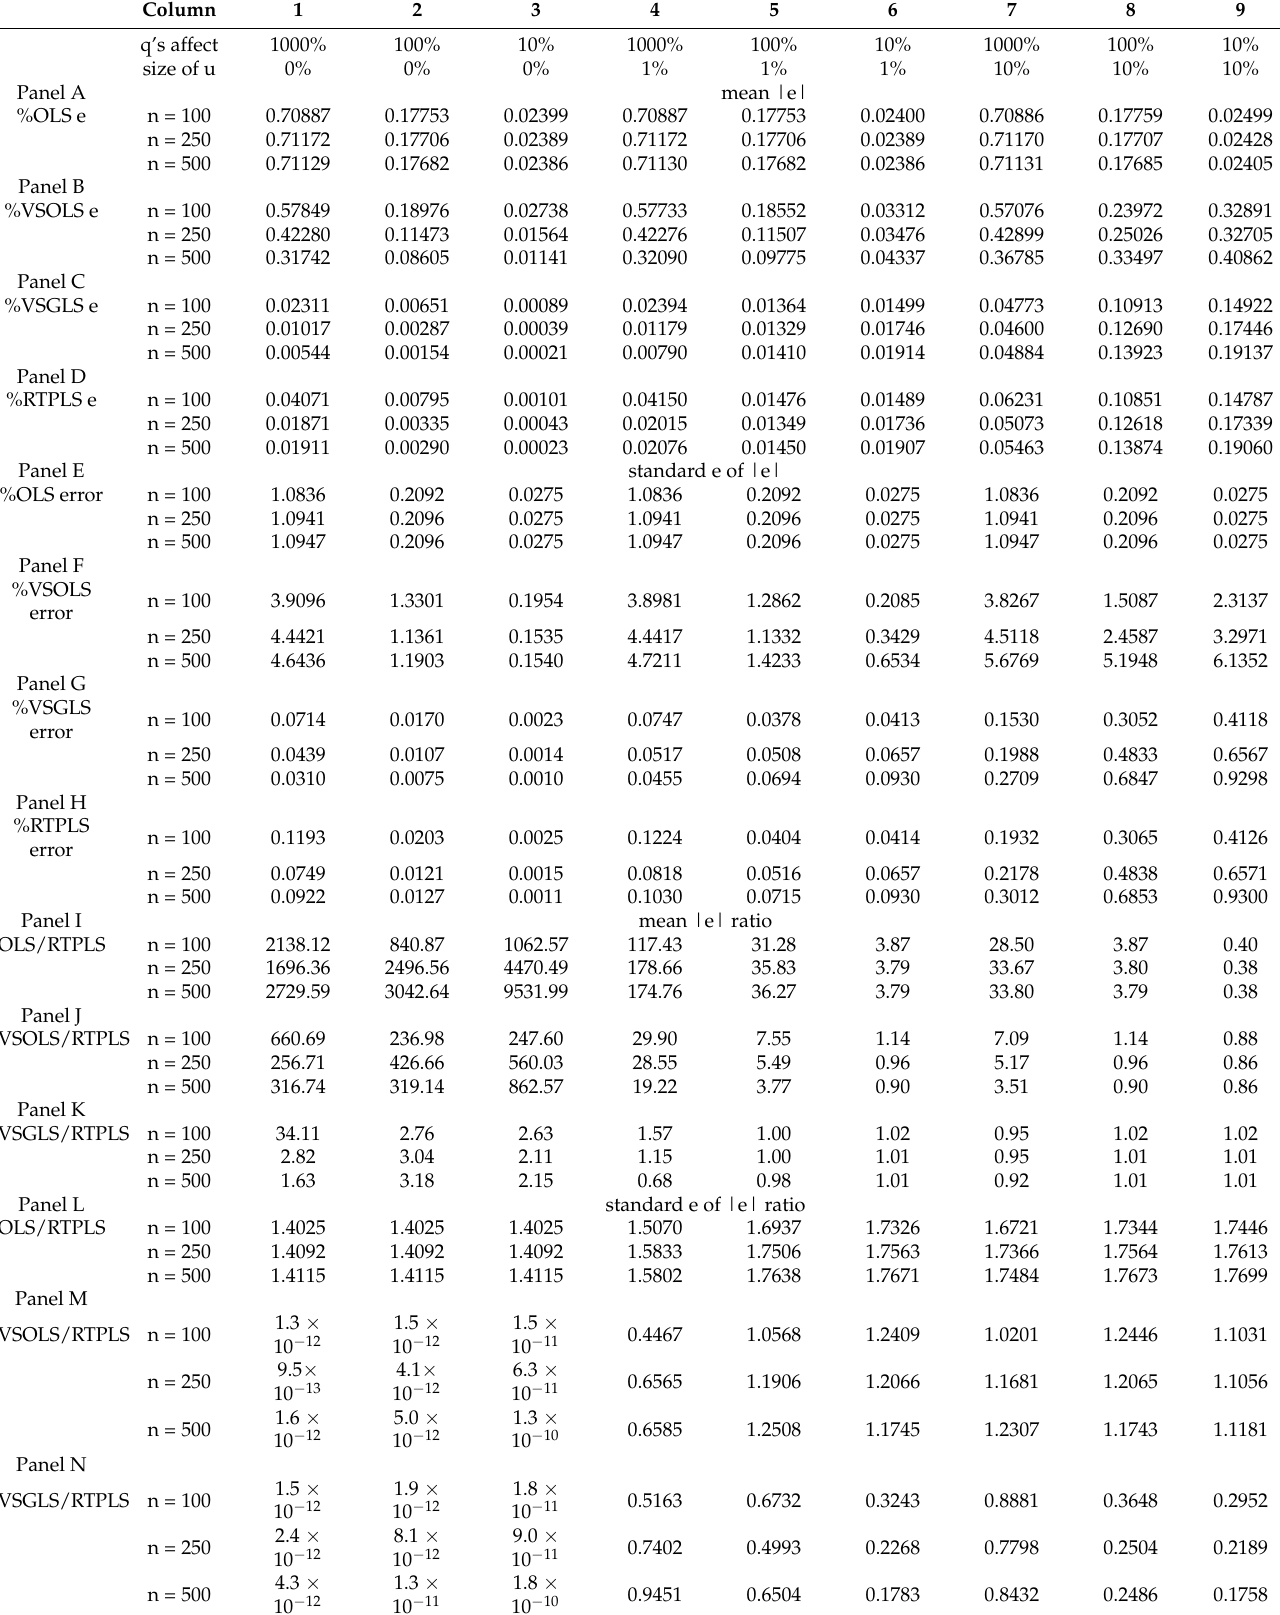
Table 1. The empirical results, 5000 simulations